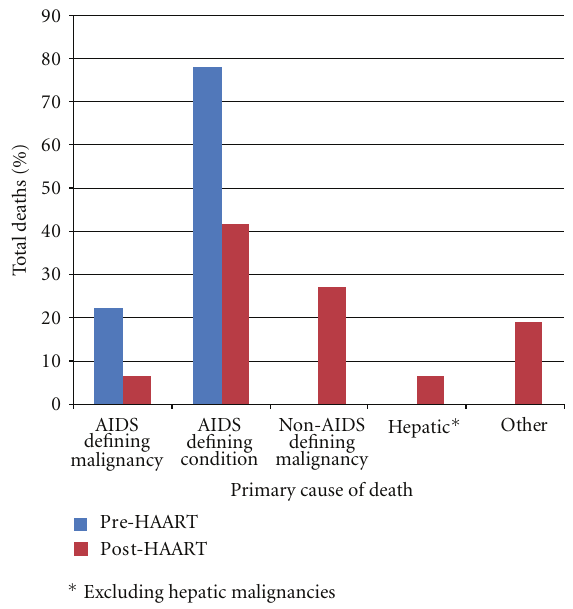
Figure 1: Primary cause of death in individuals who died at Casey House in 1988 (pre-HAART) in comparison to 2006–2008 (post- HAART).